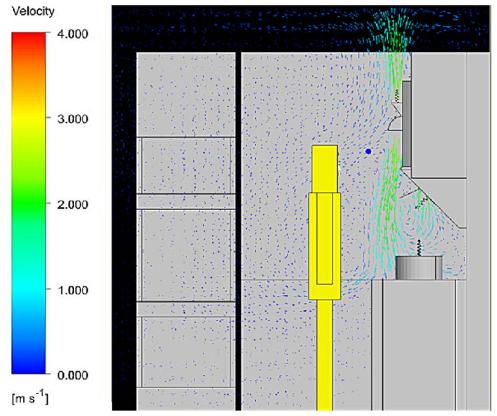
Figure 7. The fresh air direction of the upper and lower fresh air outlet. During the 1800-s test, the oil fume pan was opened twice for 40 s and was off for the rest of the time. According to the specific steps of the test, the regularity of the oil fume release rate and concentration of No. 1 oil fume pan with time is shown in Figure 8. During the two time periods of 56~95 s and 956~995 s, the No.1 oil fume pan was turned on. To evaluate the effect of the fresh air system on kitchen air quality, the upper and lower fresh air outlets were opened at 0~900 s and closed at 901~1800 s in the test.